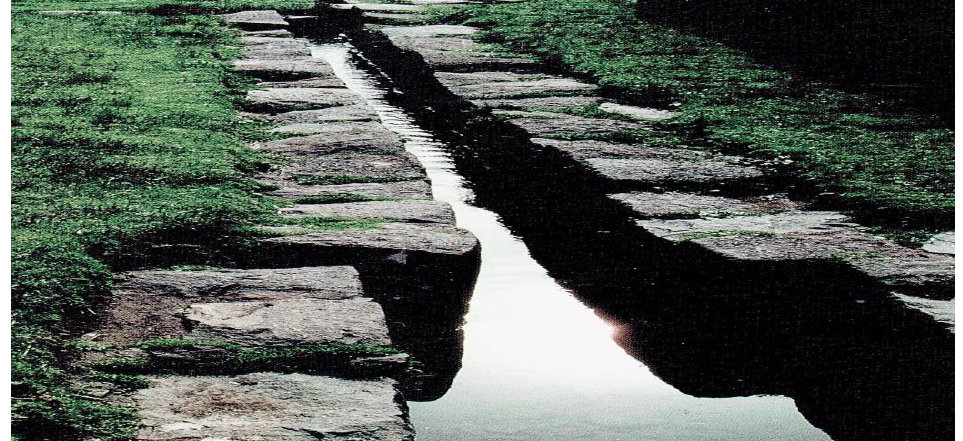
Figure 12. Transverse surface wave structure in the downstream contracted channel section indicative of induced critical flow conditions. This is an alternate view of the water flow pattern shown in Figure 11. (Photo by C. Ortloff).